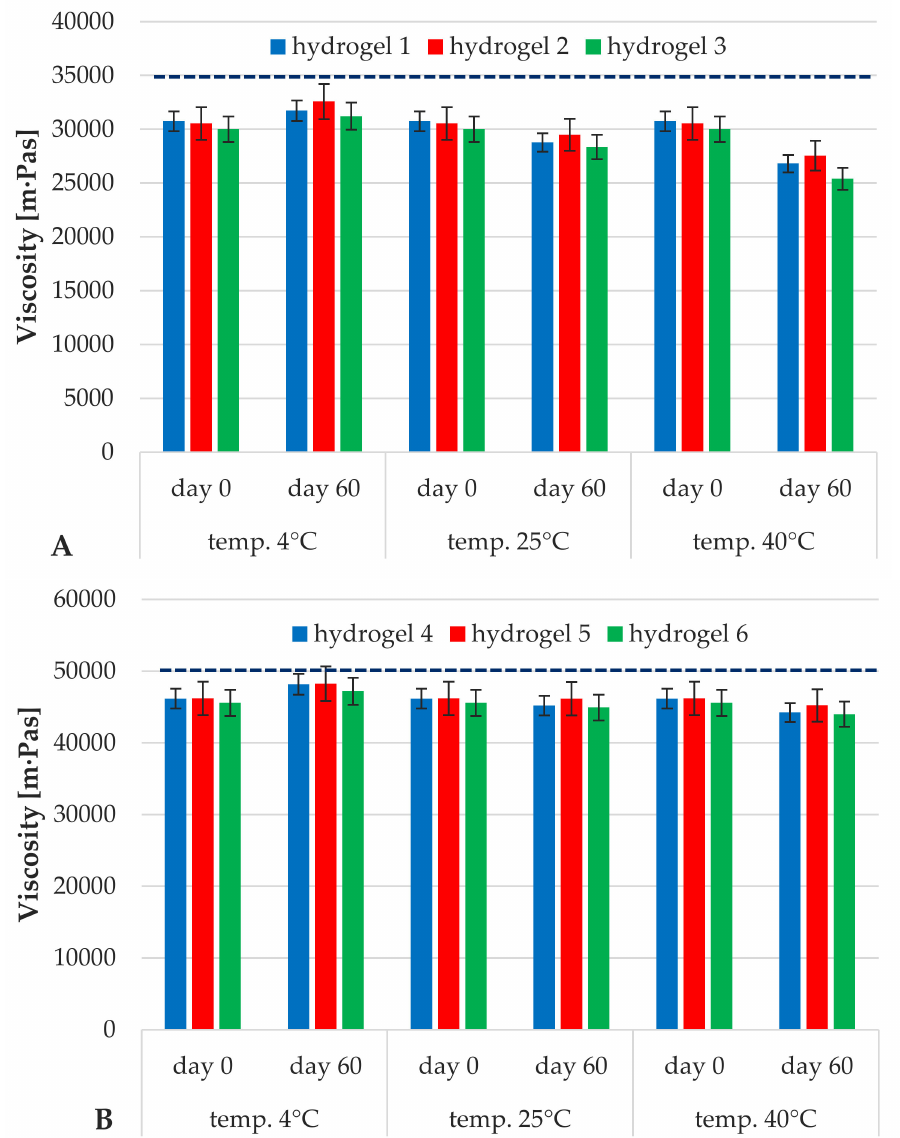
Figure 5. Changes in viscosity of the hydrogel formulations: 1–3 ( A ) and 4–6 ( B ) stored at different temperatures (4, 25, 40 ◦ C) for 60 days; spindle R4; velocity 5